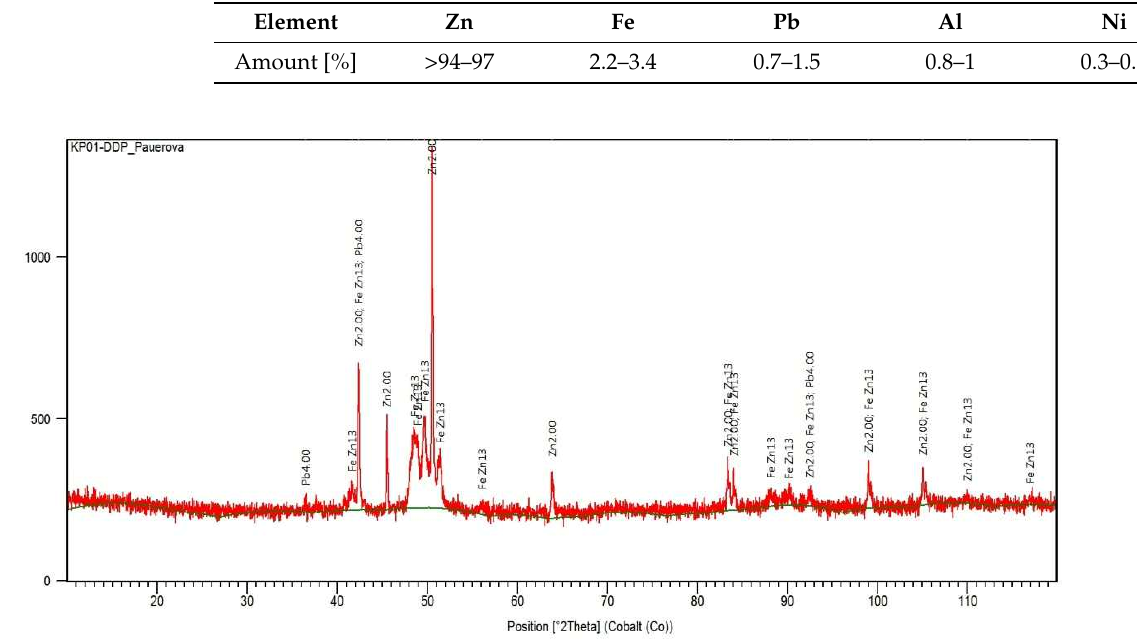
Figure 2. XRD pattern of the bottom zinc dross sample [36]. Table 2. Results of the XRD analysis—phase composition of the sample. Ref.